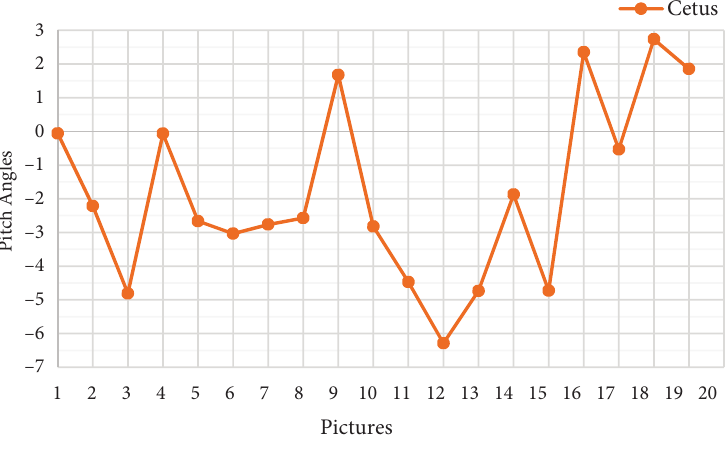
Figure 4. Values of “Cetus” UAV pitch angles